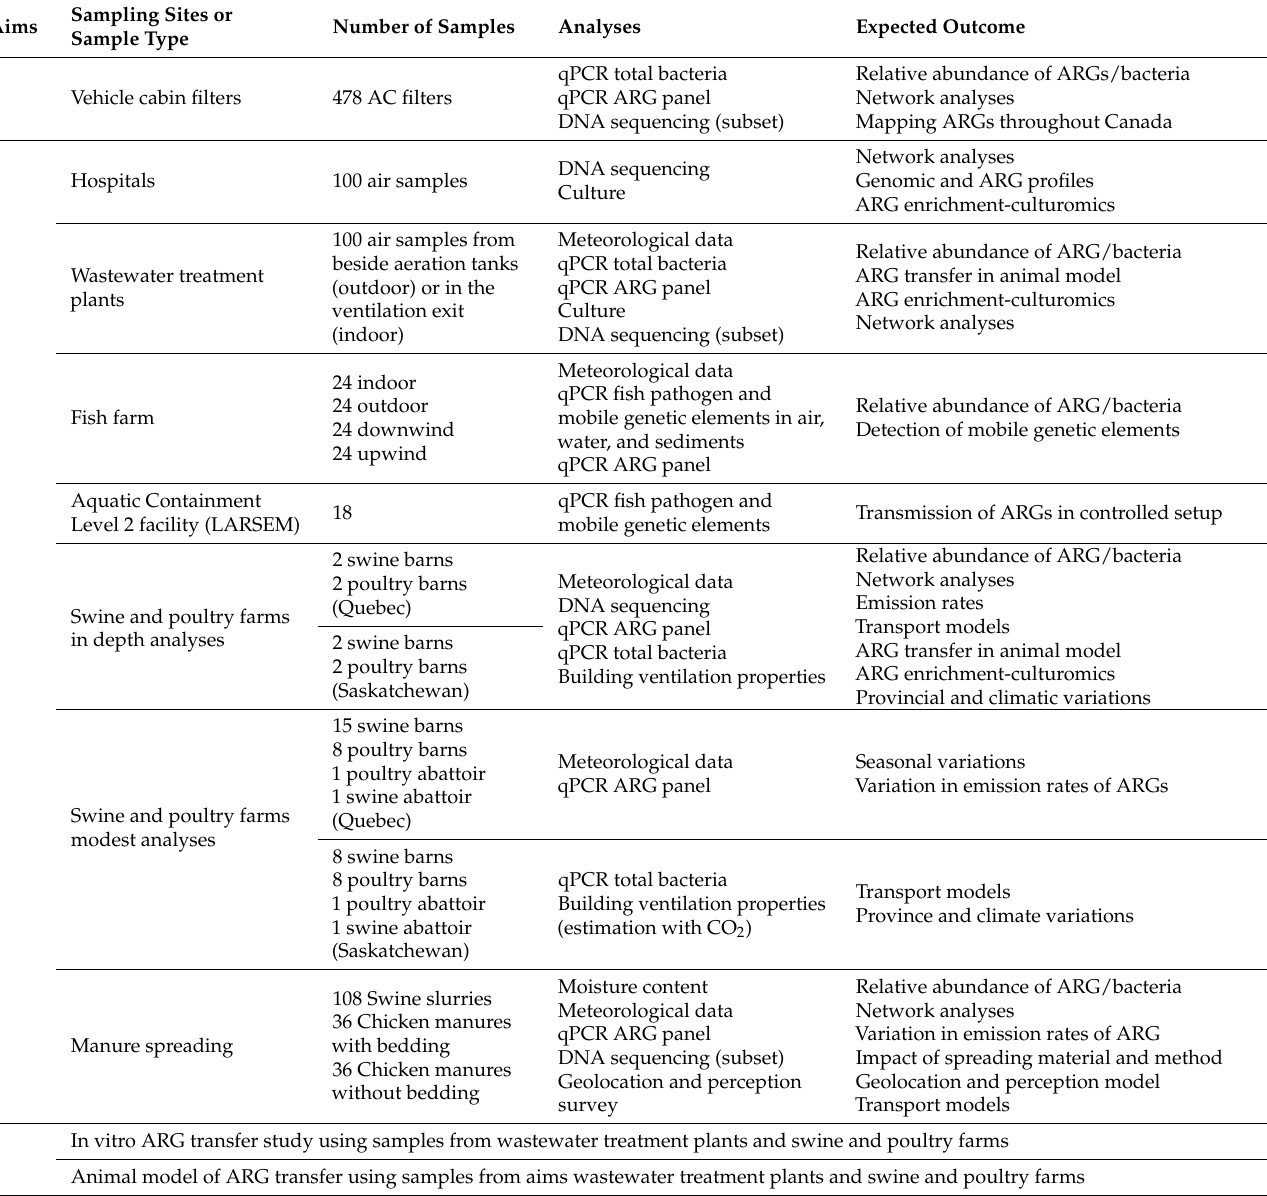
Table 1. Summary of sampling sites, number of samples, type of analysis, and